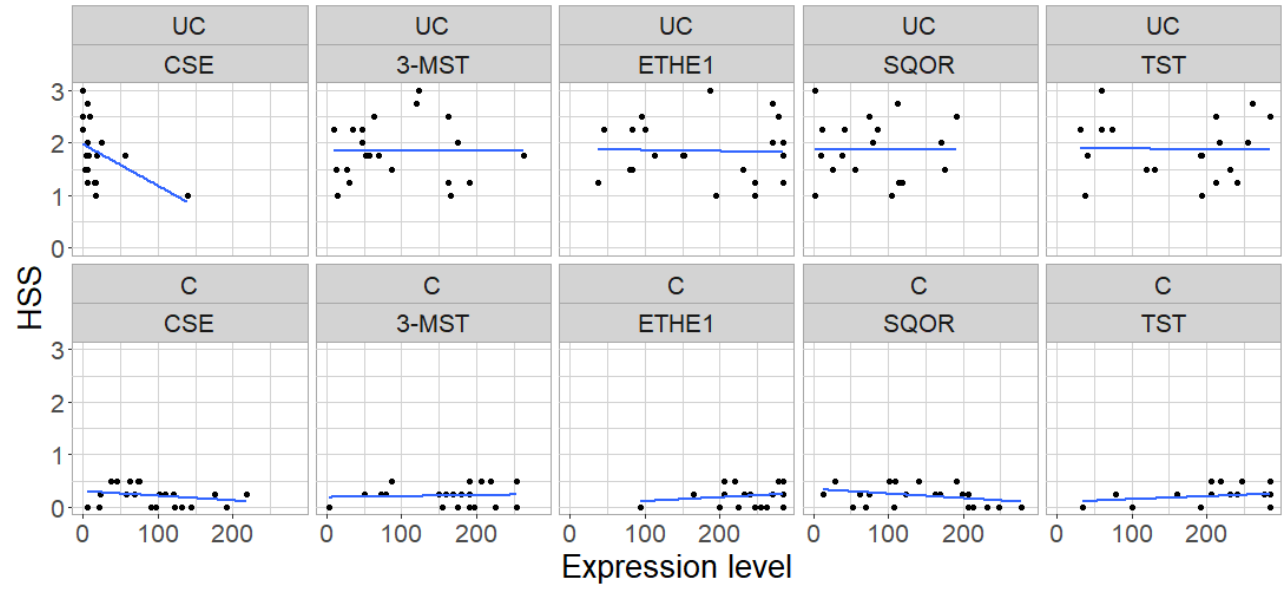
Figure A2. Expression levels of cystathionine- γ -lyase (CSE), 3-mercapto-sulfurtransferase (3-MST), ethylmalonic encephalopathy 1 protein (ETHE1), Sulfide:quinone oxidoreductase (SQOR) and thiosulfate sulfurtransferase (TST) of biopsies from the rectum compared to the histologic severity score (HSS) of each sample, separated into ulcerative colitis (UC) and controls (C).